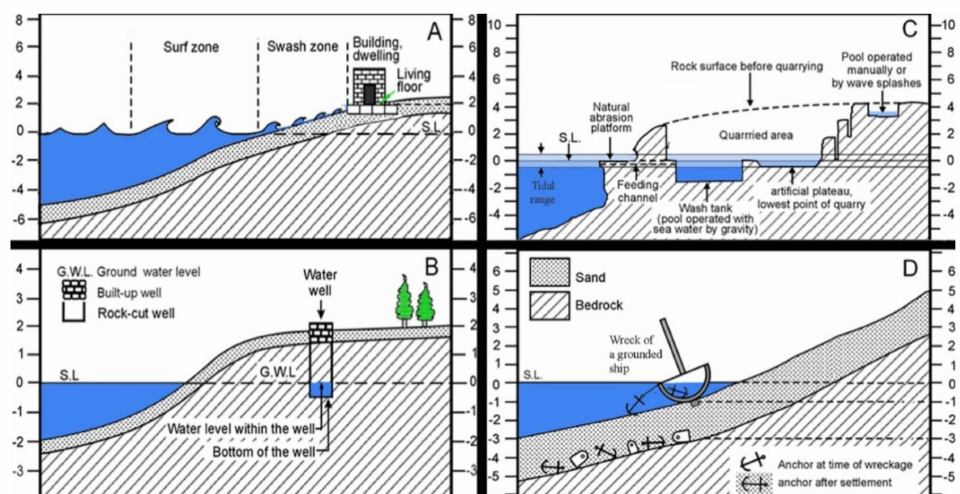
Figure 3. Archaeological features used as sea-level markers during the time of their functioning: ( A ) dwelling floor gives the uppermost possible sea-level elevation, ( B ) water well gives the upper and lower elevation of sea levels, ( C ) rock-cut pools fed with sea water by gravity provide the upper and lower sea-level elevations, ( D ) grounded shipwreck provides the lowest possible sea level